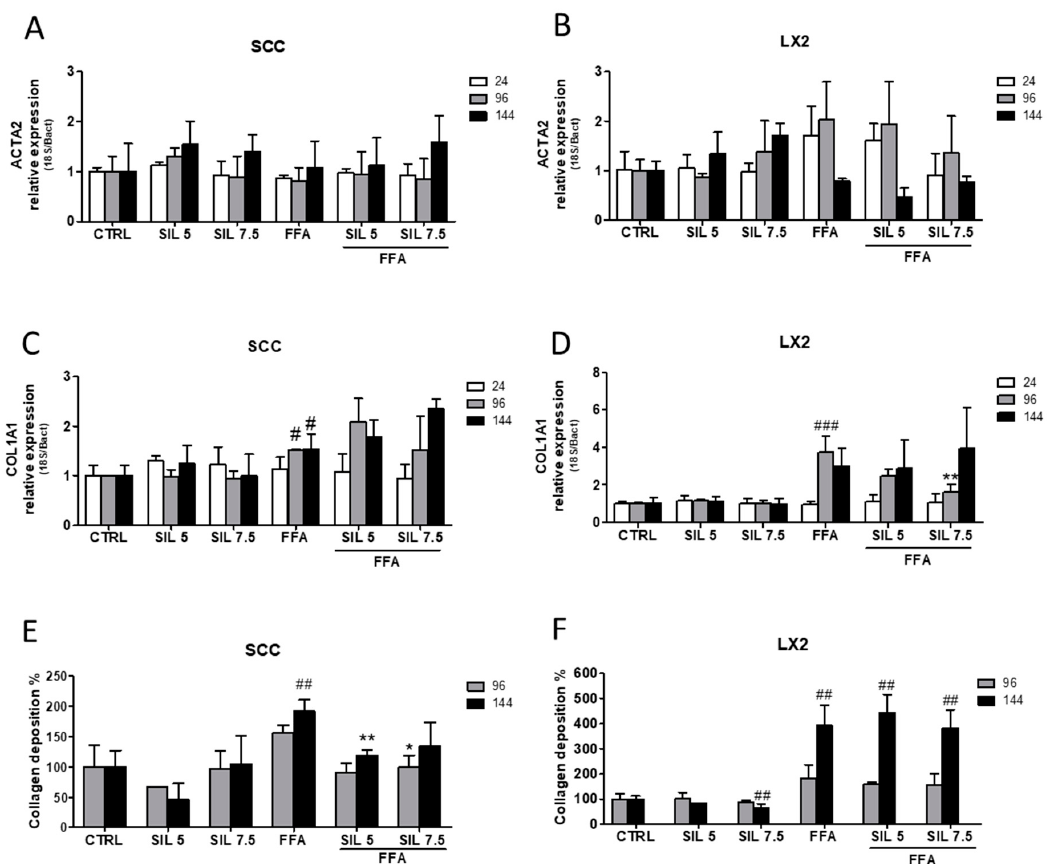
Figure 2. Effect of Silybin on HSC (LX2) activation and collagen production. ACTA2 ( α -SMA) gene expression upon FFA and Silybin exposure in SCC ( A ) and LX2 ( B ) vs. control. COL1A1 gene expression upon FFA and Silybin exposure in SCC ( C ) and LX2 ( D ) vs. control. Quantification of the total extracellular collagen upon FFA and Silybin exposure vs. control in SCC ( E ) and LX2 ( F ). # p < 0.05, ## p < 0.01, ### p < 0.001 vs. CTRL; * p < 0.05, ** p < 0.01 vs. FFA.